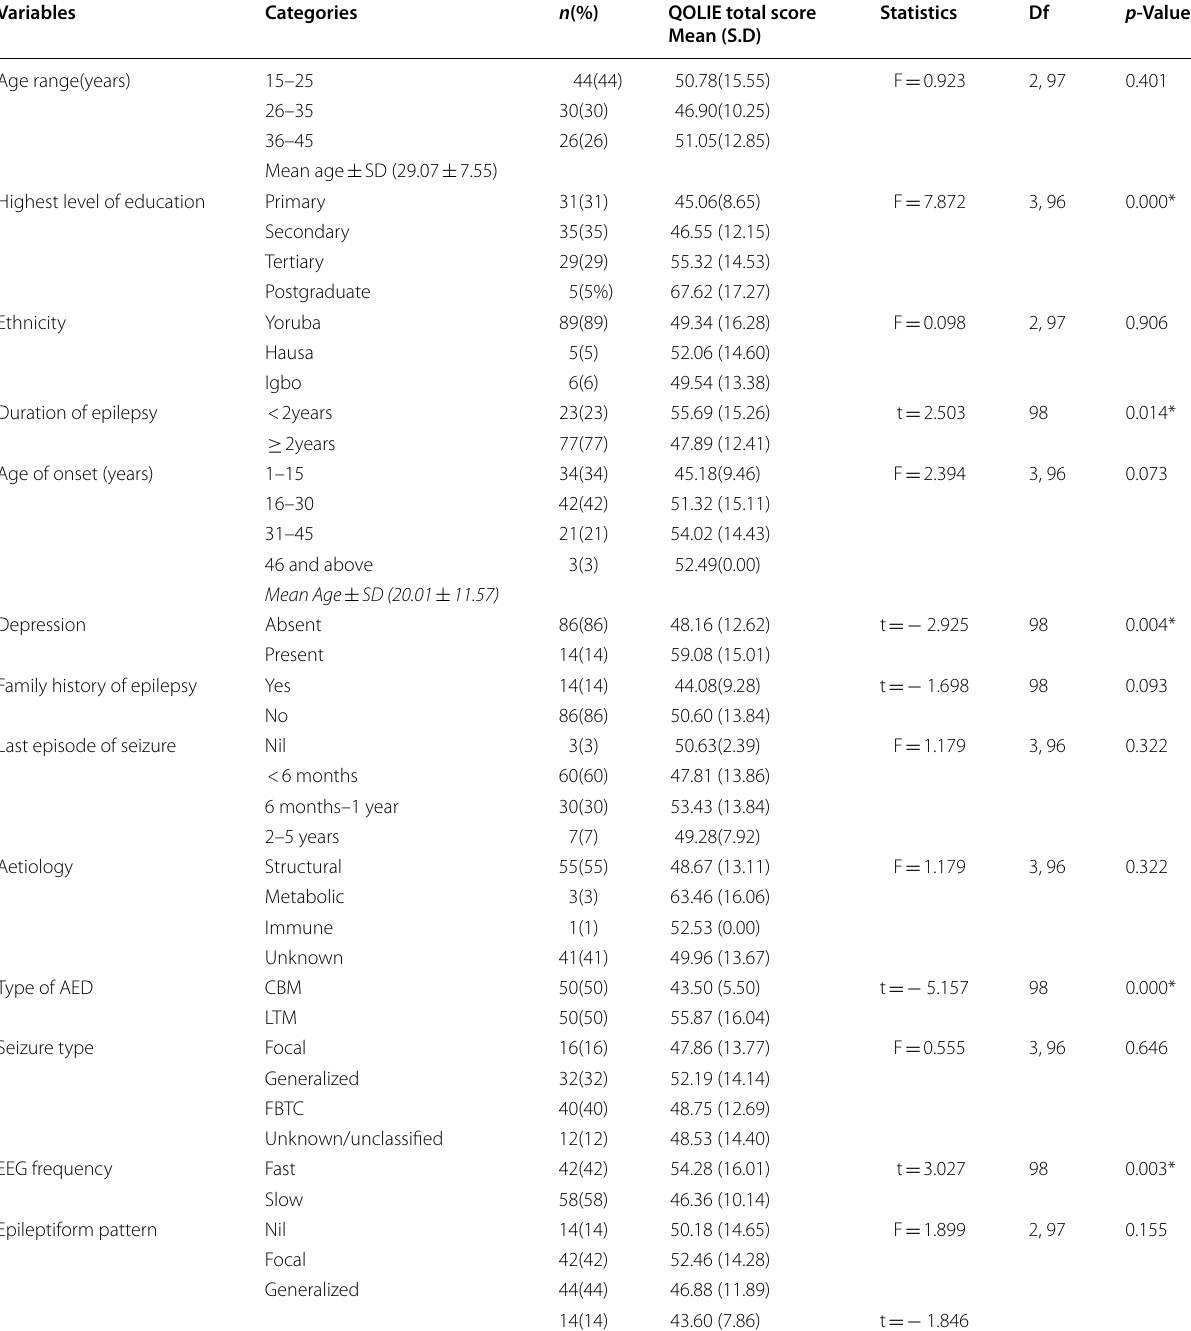
Table 1 relationship between socio‑demographic and clinical characteristics and